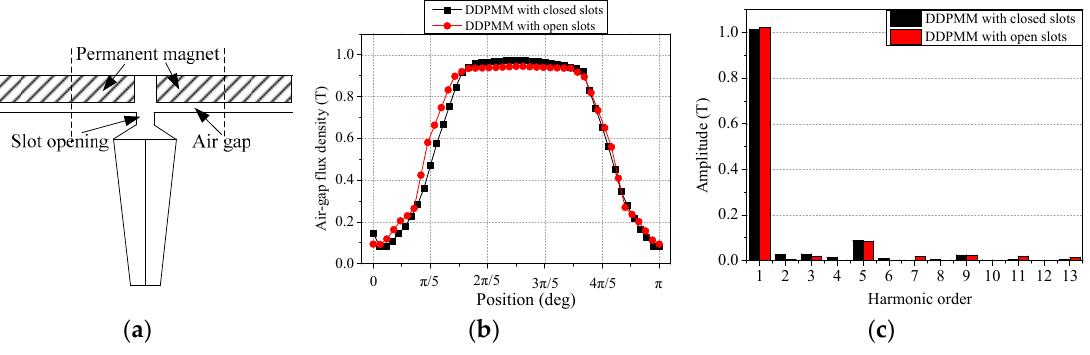
Figure 7. Magnetic field analysis at position 3: ( a ) position 3; ( b ) air-gap flux density waveforms; ( c ) harmonics of air-gap flux density.